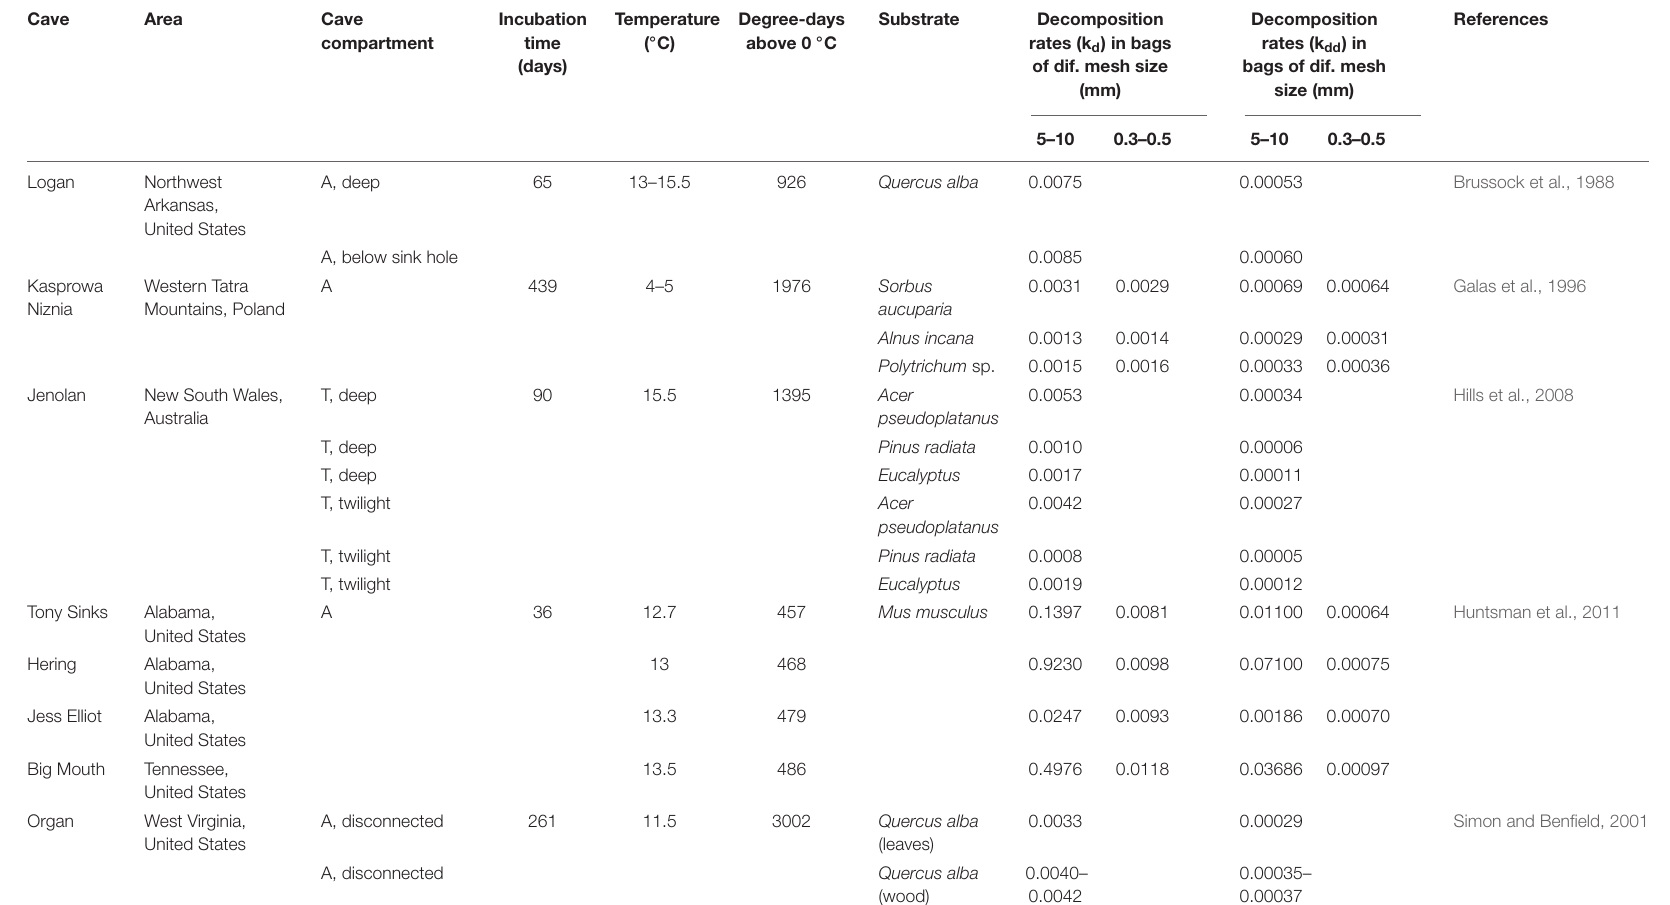
TABLE 1 | Available data on decomposition rates in